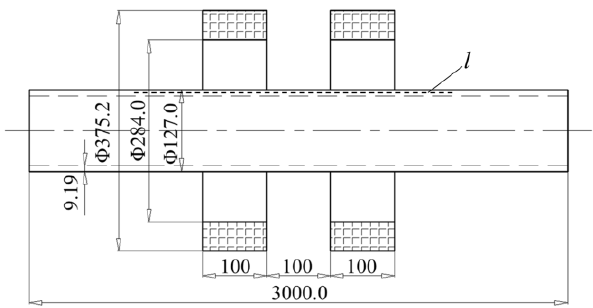
Figure 1. The simulation model for the 5 in. drill pipe magnetized by the Helmholtz coil (unit: mm).